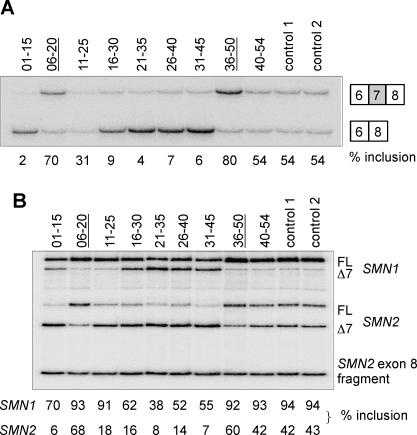
In Vivo Validation of the Initial ASO WalkEach ASO at a concentration of 10 μM and 2.5-μg pBabe Puro with or without 5-μg pCI-SMN2 were transfected by electroporation, and transfected cells selected with 2-μg/ml puromycin for 20 h. Two days after transfection, cells were collected for total RNA preparation, and RT-PCR was performed to analyze SMN2 pre-mRNA splicing patterns. The PCR products were labeled by incorporation of α-32P-dCTP. The ASOs that promote exon inclusion are underlined. Control 1: unrelated oligonucleotide 00–00; control 2: buffer.(A) The nine ASOs were co-transfected with pCI-SMN2, and the PCR products analyzed by 8% native PAGE.(B) The effects of the nine ASOs were analyzed with transcripts from the endogenous SMN2 gene in HEK293 cells. RT-PCR products were digested with DdeI to distinguish SMN1 from SMN2 by 6% native PAGE. The percentage of exon 7 inclusion in each lane is indicated below each autoradiogram. FL, full-length mRNA; Δ7, exon 7–deleted mRNA.